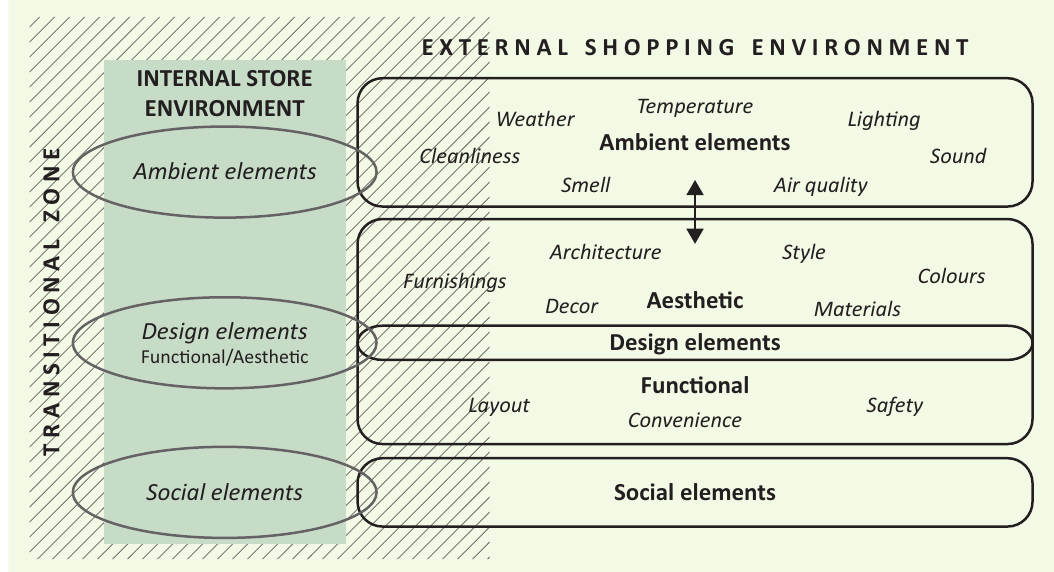
Figure 1. The external elements in the physical shopping